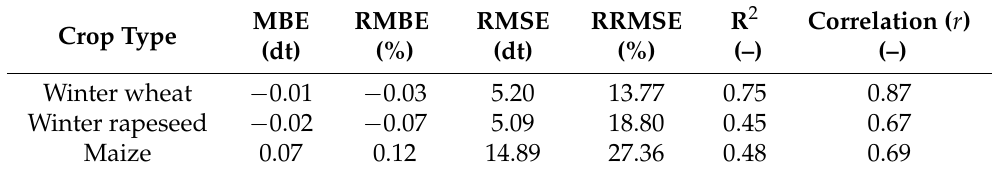
Table 4. Overall performance of crop yield forecasts at LAU level.